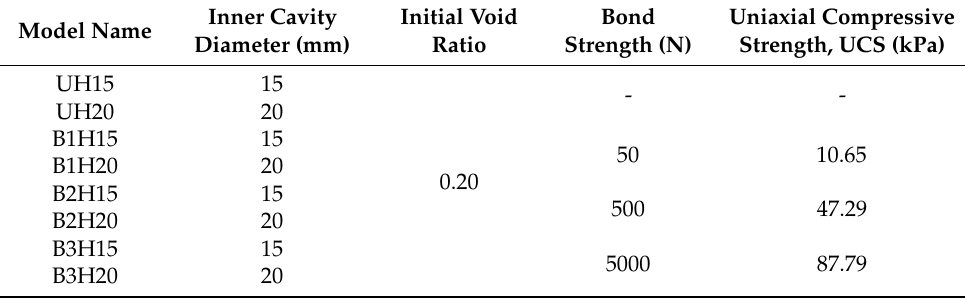
Table 3. The properties of models used in the sand production test simulation.